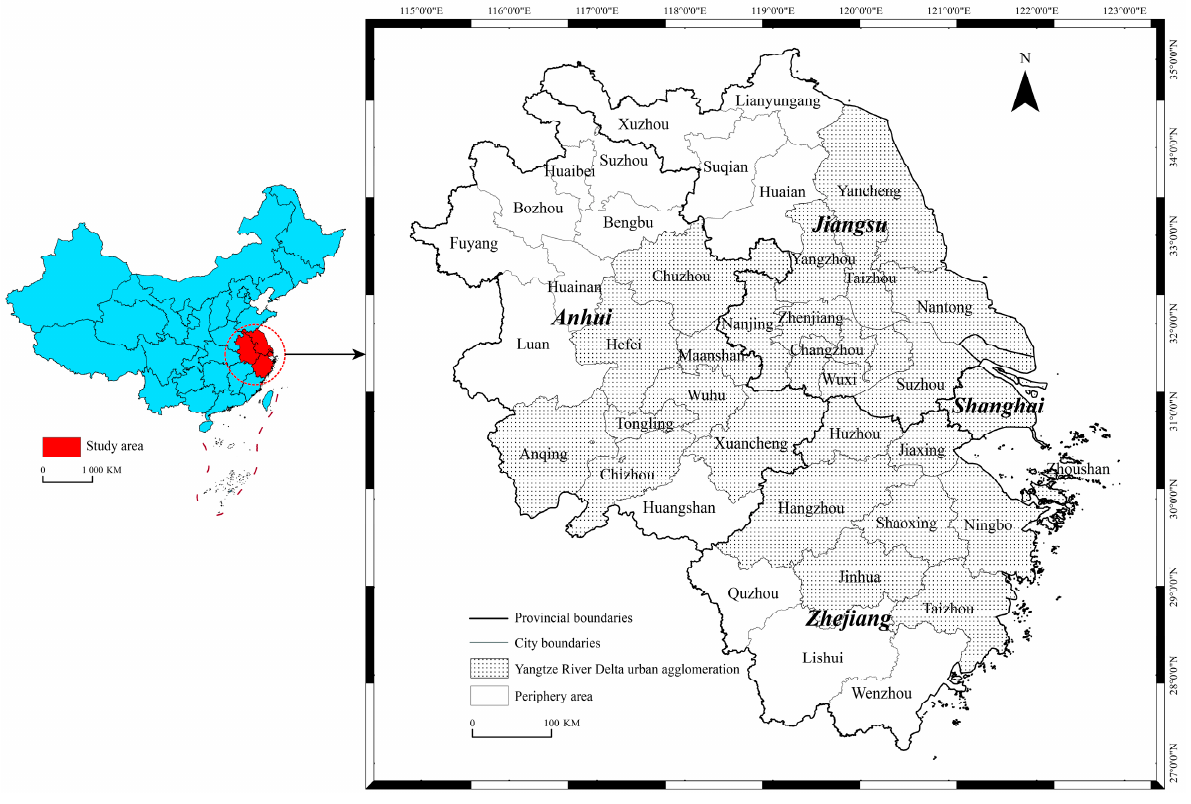
Figure 1. Study area.